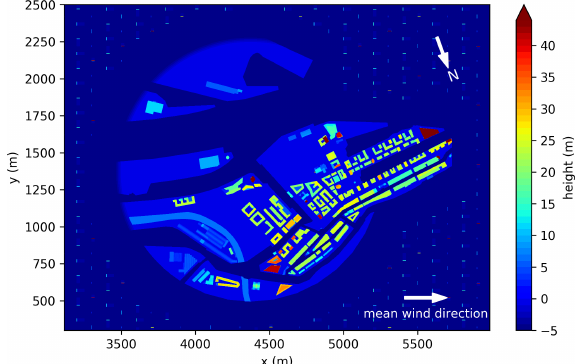
Figure 4. Building layout and heights as used in the PALM simu- lation. The x direction is oriented to follow the mean wind direc- tion. The total domain size is 6000, 2880, and 601m in the x , y , and z direction, respectively. Note that z = 0m is defined at street- level height while the lowest level within both experiments was at z = − 5m, which is the water-level